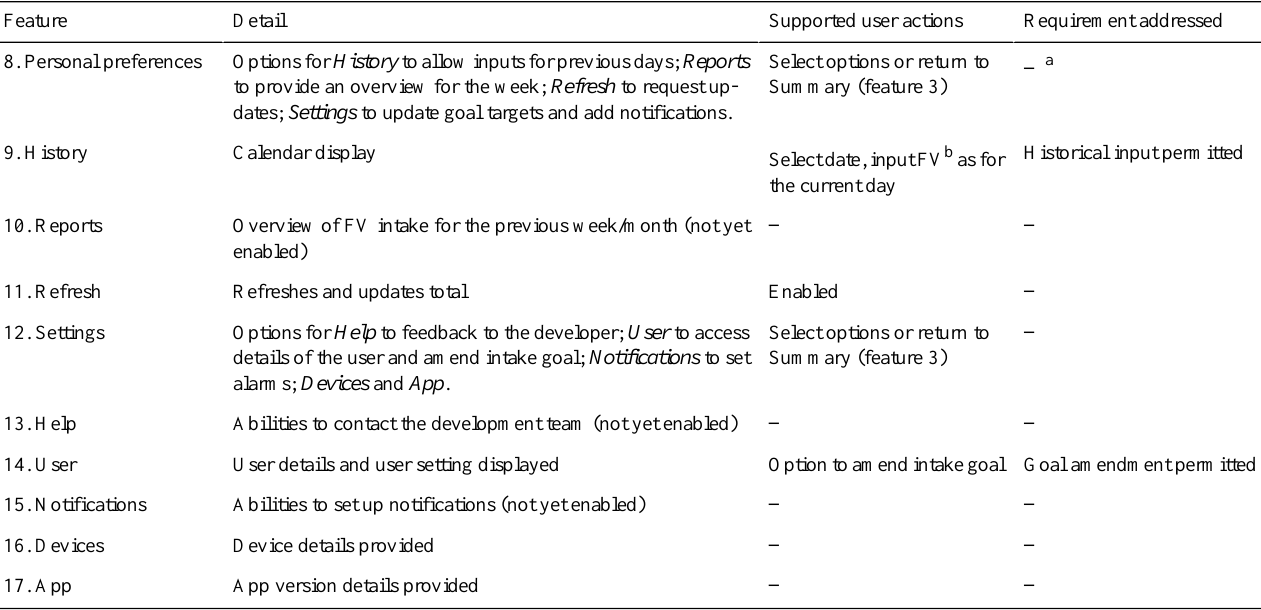
Table 5. Additional screens of the final